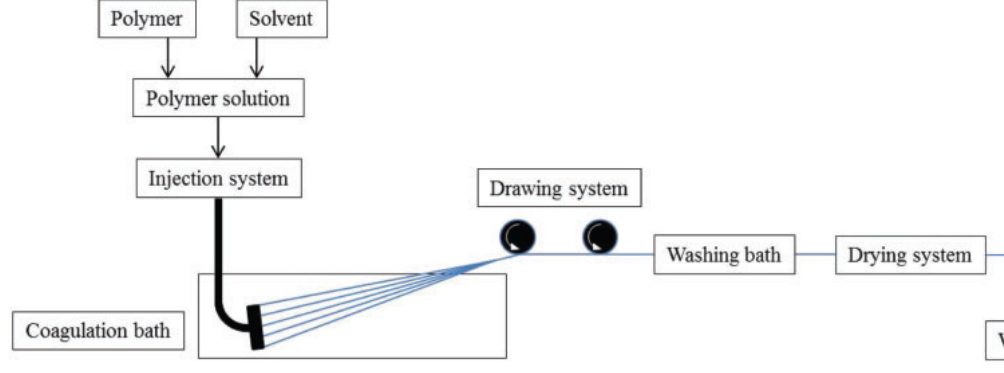
The melt-spinning process: where phase transforma- tion is due to the solidification from a molten mass.